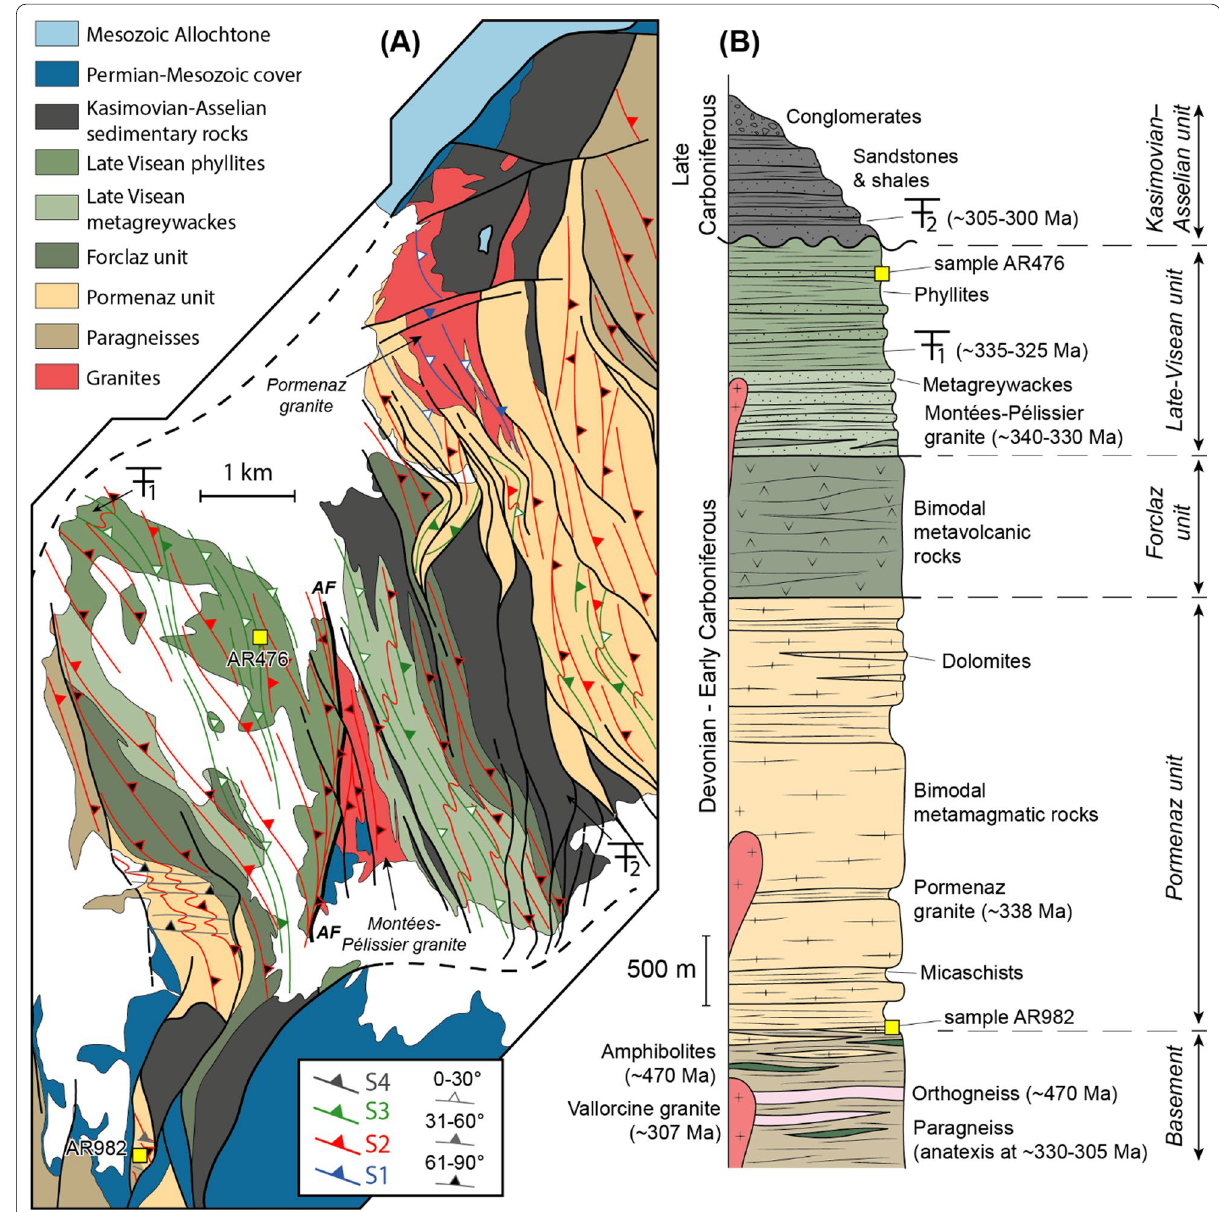
Fig. 2 A Map of the Servoz syncline, modified from Dobmeier (1996). B Synthetic stratigraphic Log of the Servoz syncline, modified from Pairis et al. (1992), Dobmeier (1996) and Dobmeier et al. (1999). Fossil occurrences are from Laurent (1967) and Bellière and Streel (1980). U–Pb Age of meta‑igneous rocks are from Bussy et al. (2000) and Vanardois et al., (2022a, 2022b). AF: Arve